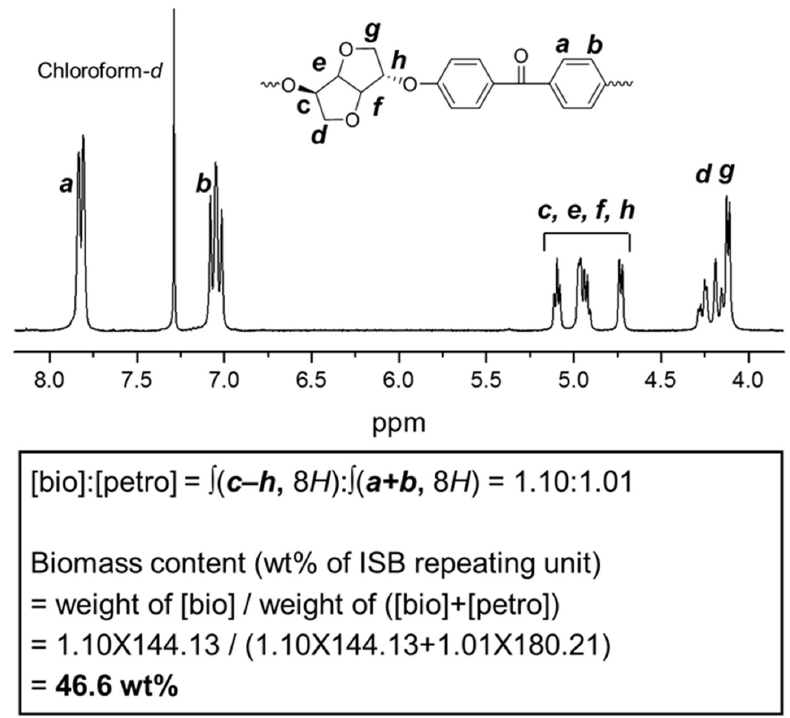
Figure 3. 1 H-NMR spectrum of IK-110 and calculation of biomass content.